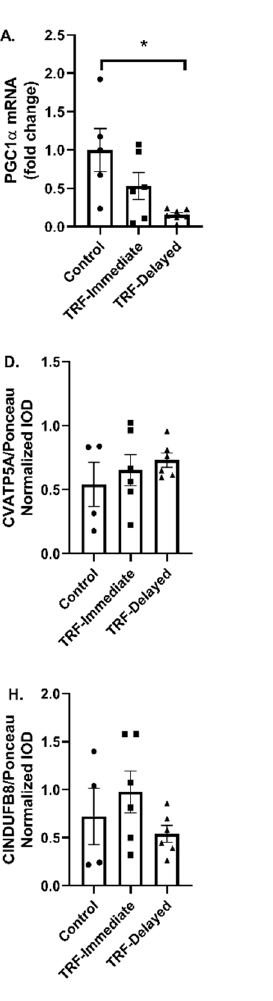
Figure 5. Markers of mitochondrial biogenesis and content after acute exercise in gastrocnemius of mice exposed to 8 weeks of training and TRF. ( A ) PGC-1 α mRNA and ( B ) protein expression was measured in the gastrocnemius. ( C ) TFAM mRNA expression and ( D ) CVATP5A, ( E ) CIIUQCRC2, ( F ) CIVMTC01, ( G ) CIISDHB, ( H ) CINUUFB8 were measured in the gastrocnemius. ( I ) Representative Western blot images. All protein data were normalized to Ponceau stain loading control. Data are presented as mean ± SEM. One-way ANOVA was used to detect significance. * indicates significance p ≤ 0.05.